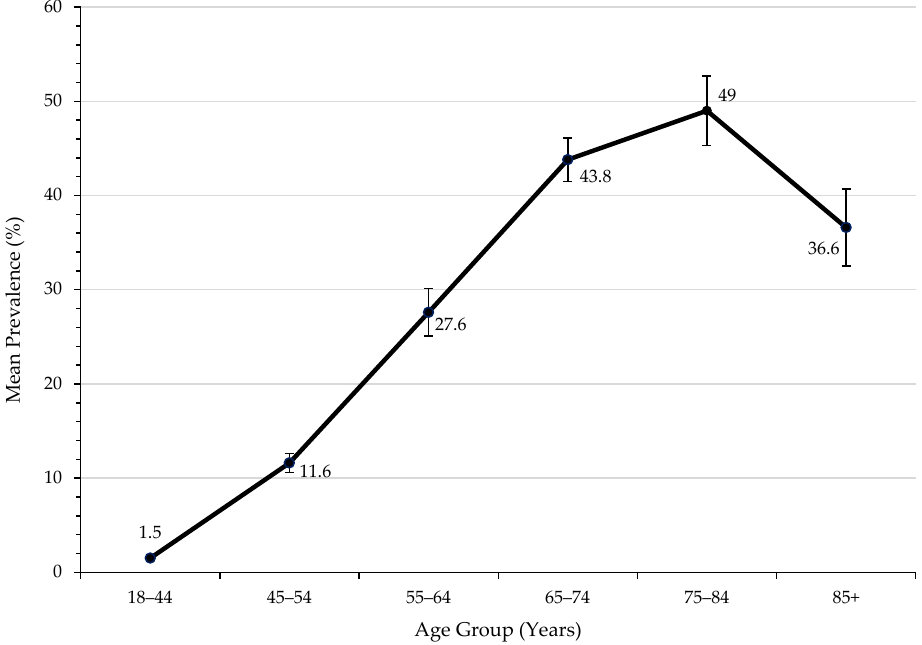
Figure 3. Prevalence of lipid-lowering medication use by age.